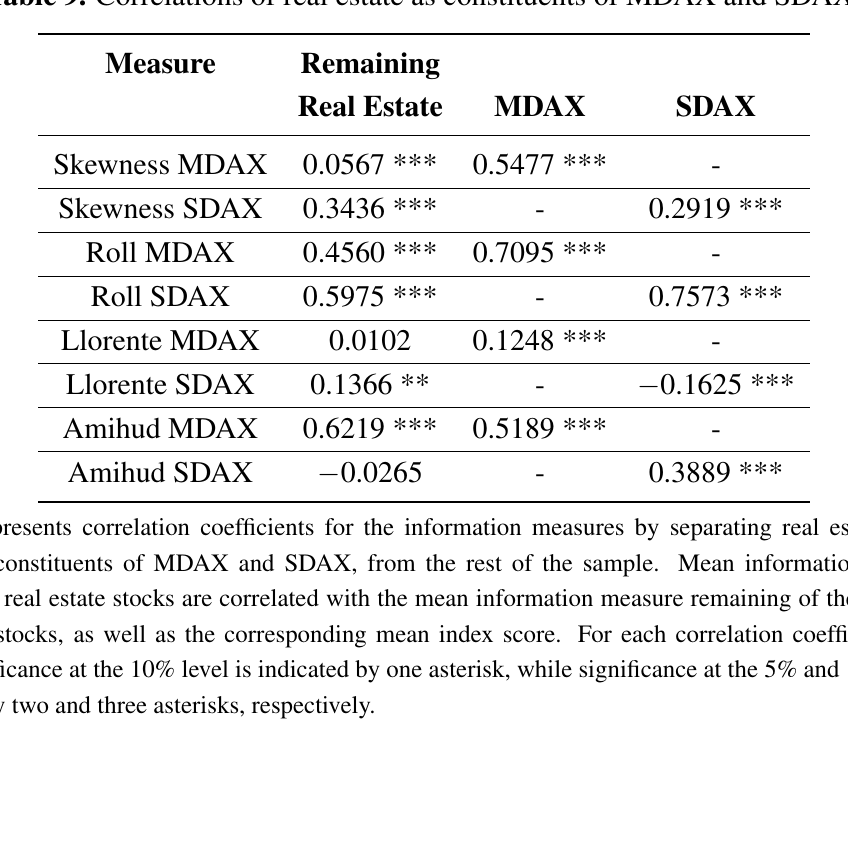
Table 9. Correlations of real estate as constituents of MDAX and